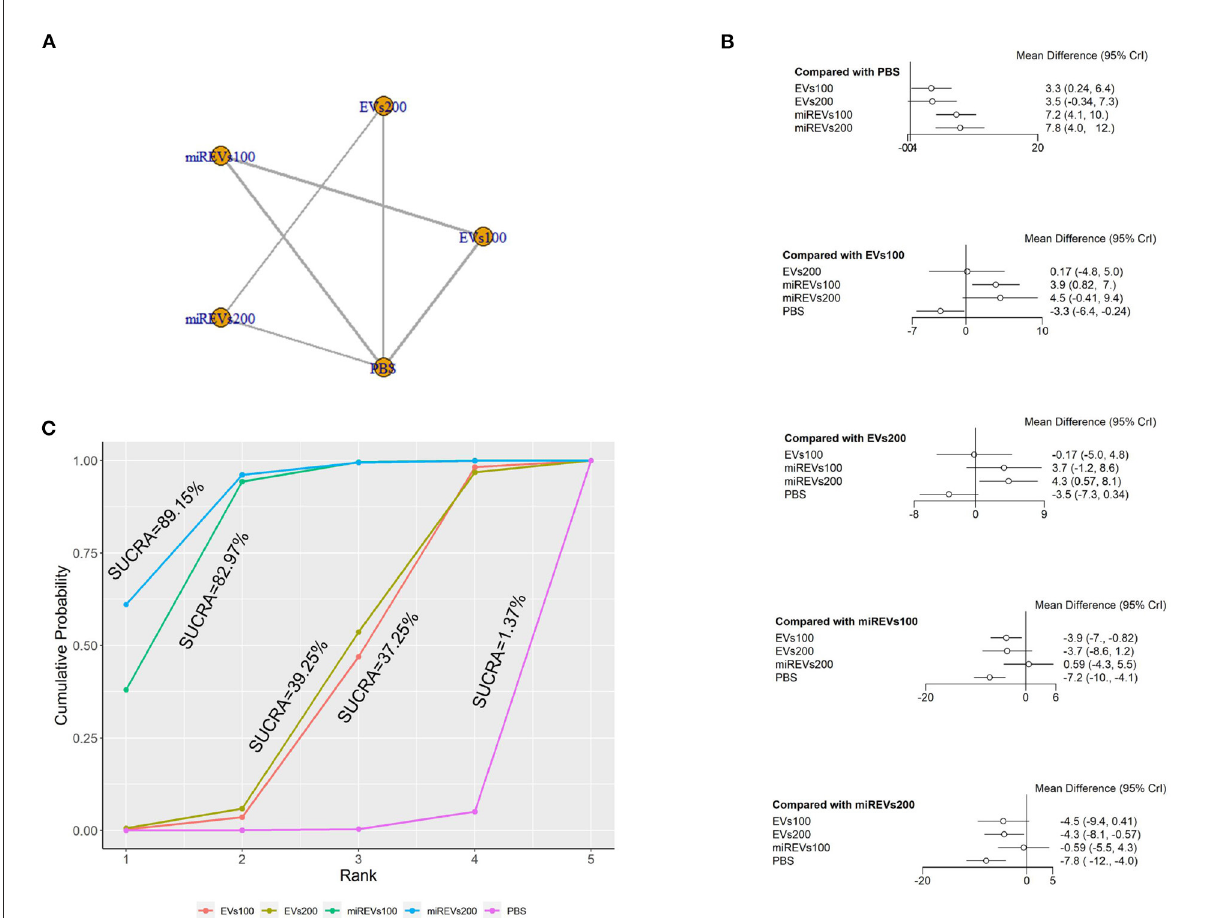
FIGURE6 The network meta-analysis of BBB scores at different dosages at 28 days after administration. (A) Network plot; (B) Forest plot; (C) SUCRA plot. EVs100, EVs at 100 µ g dosages; EVs200, EVs at 200 µ g dosages; miREVs100, miRNAs-loaded EVs at 100 µ g dosages; miREVs200, miRNAs-loaded EVs at 200 µ g